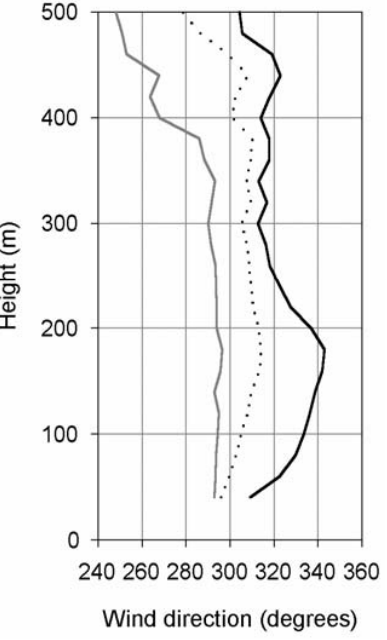
Fig. 5. Resulting direction calculated by average of unit vectors. The dotted line corresponds to the whole day, black line for the night and grey line for the day.